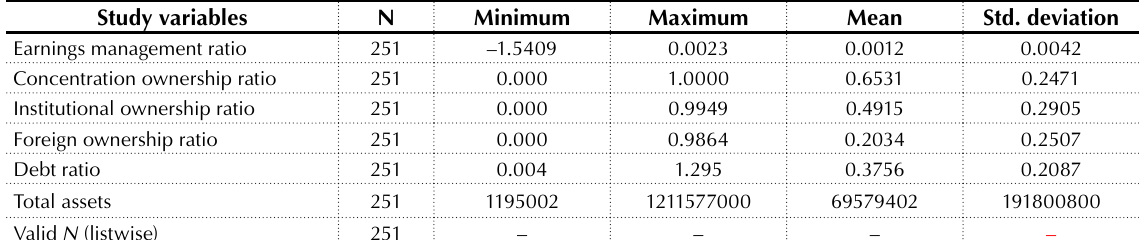
Source: Result output from SPPS statistic